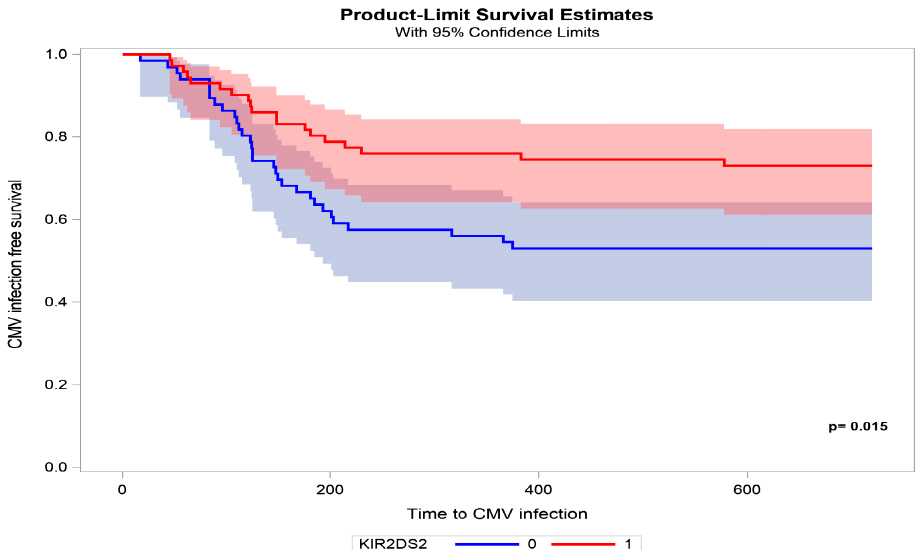
Figure 3. Time from kidney transplantation to CMV infection in patients with (red line) vs. without (blue line) KIR2DS2.